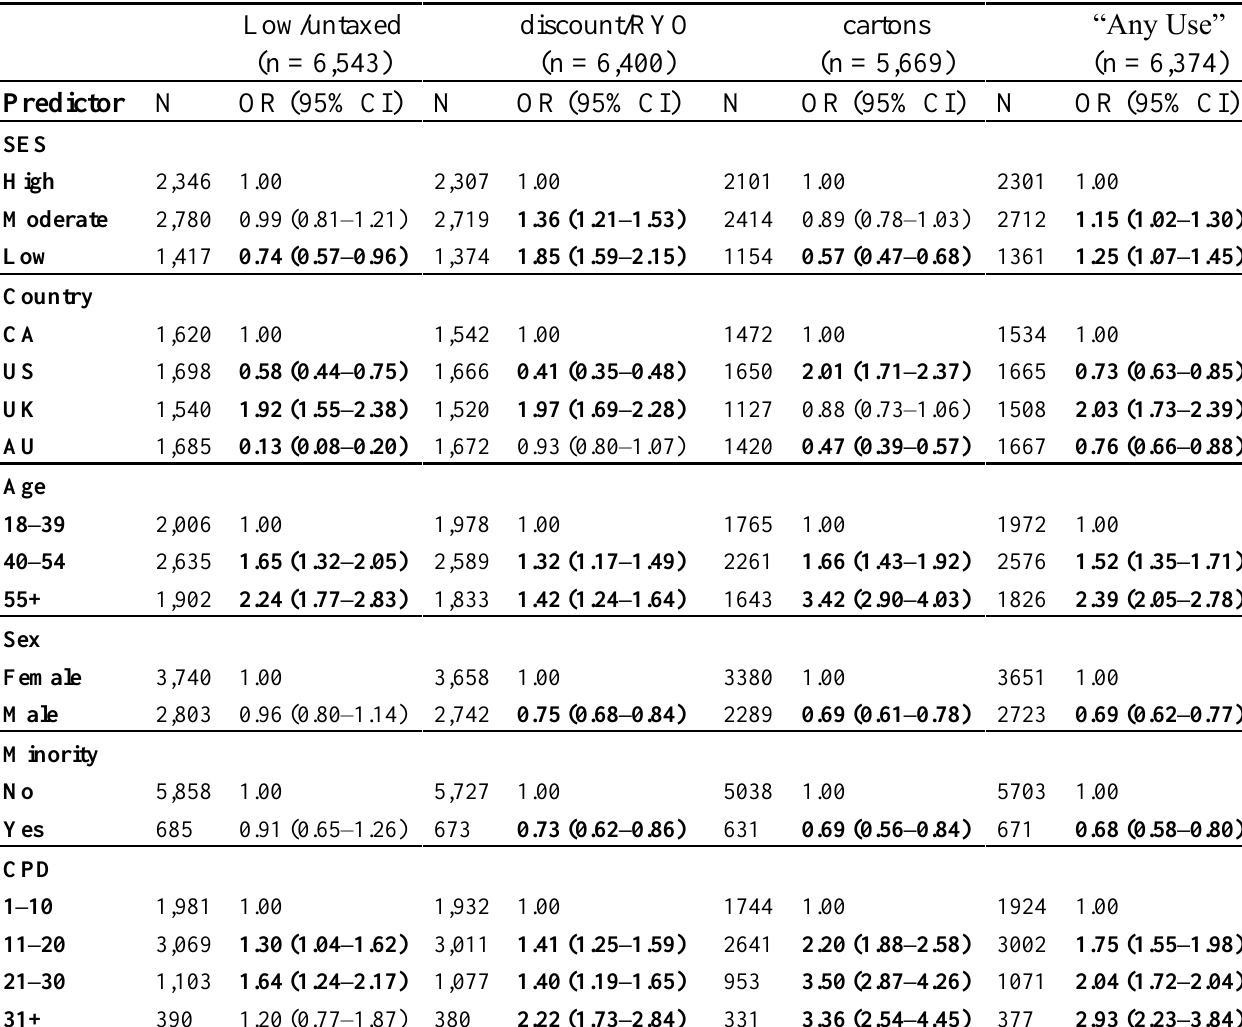
Table 4. Predictors of using Low and Untaxed Sources, Cheaper Brands/RYO, Cartons, and Any Price/Tax Avoidance Behaviors at last